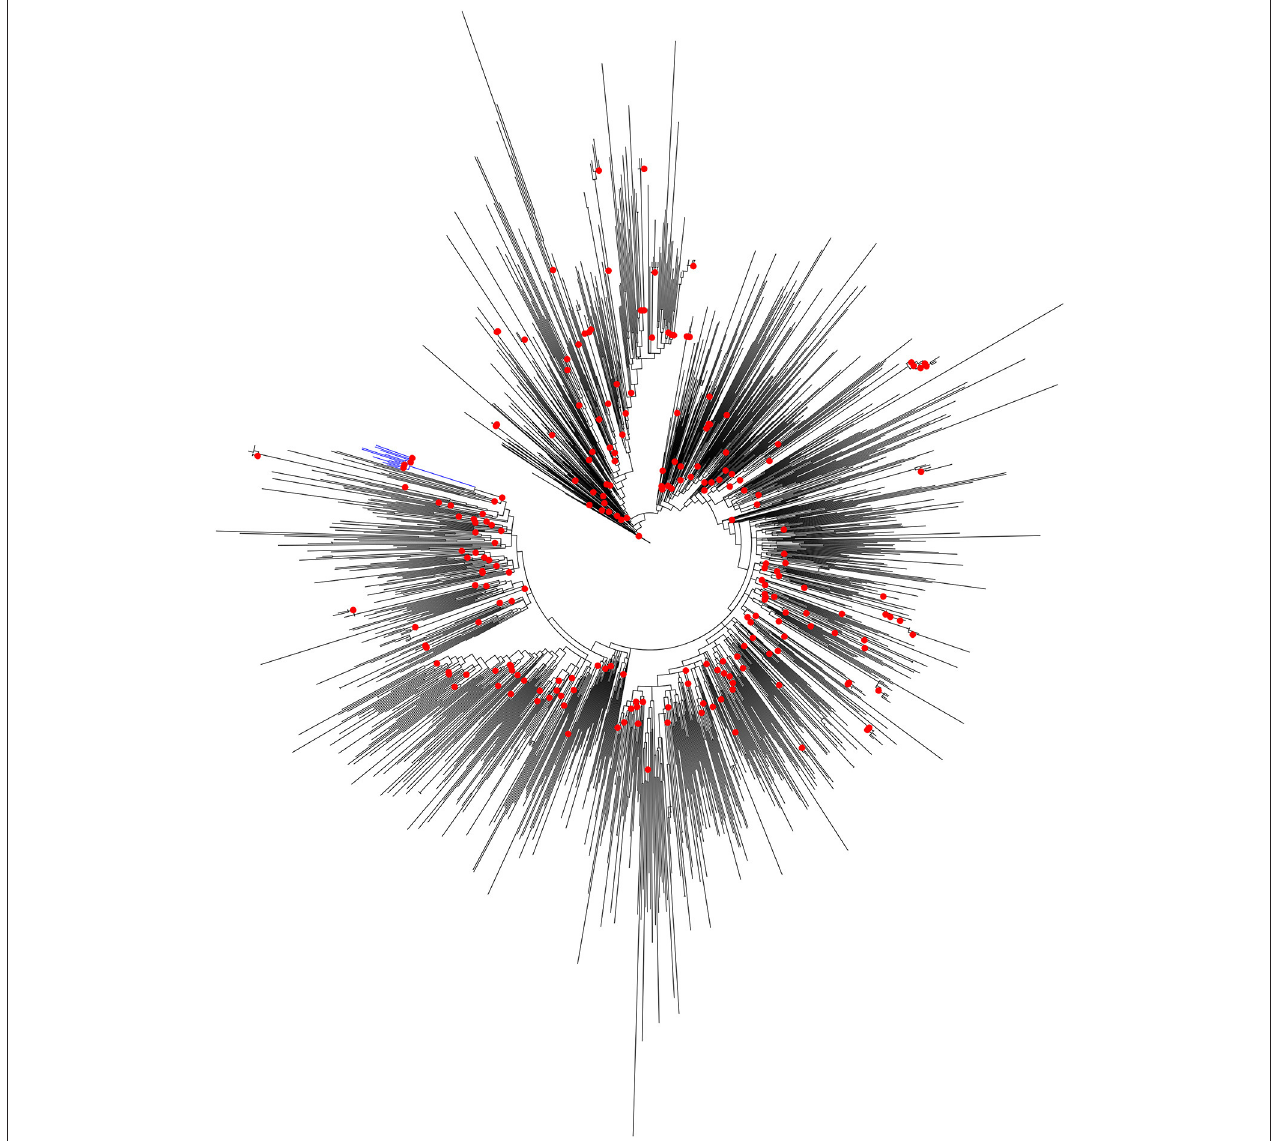
FIGURE 1 | Maximum-likelihood phylogenetic tree depicting the phylogenetic relatedness of Unnao HIV-1C pol gene sequences with other Indian HIV-1C pol gene sequences available in Los Alamos HIV sequence database. Only bootstrap values of 100 are depicted with red circles at respective nodes. The node representing 14 Unnao sequences is depicted in blue